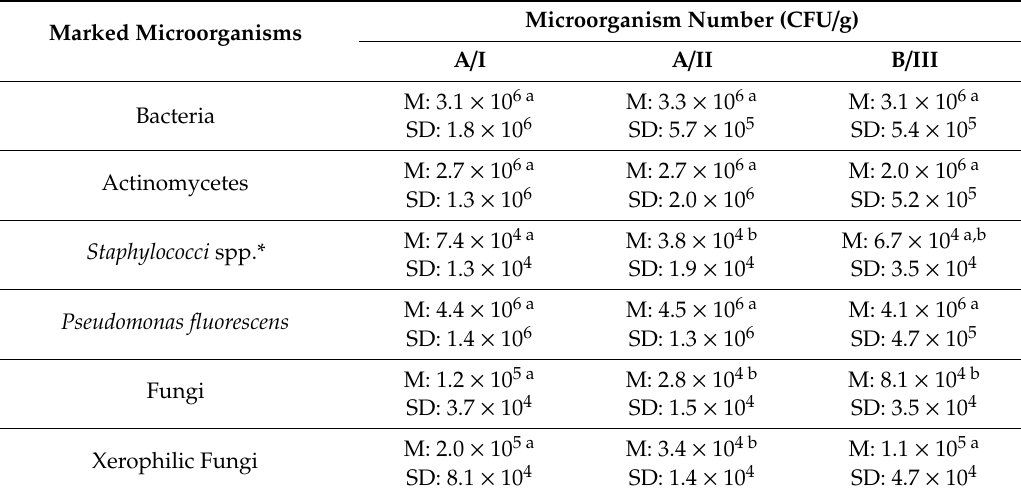
M: mean; SD: standard deviation; a, b: means with the same letter in the same row are not significantly different (test ANOVA, α = 0,05); * Mannitol-Positive and Mannitol-Negative Staphylococci spp.